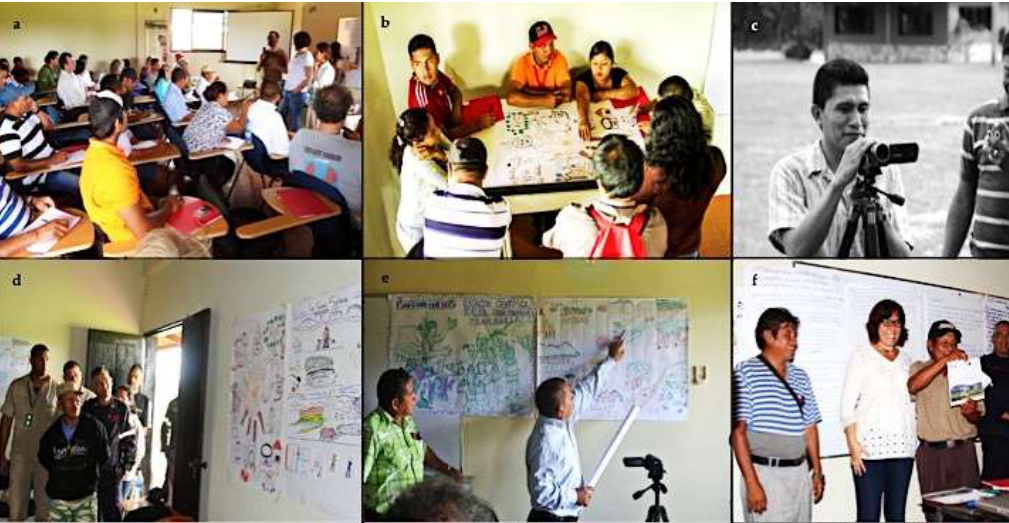
Figure 2. Illustrative images of the activities carried out during the workshop: ( a ) general view of the participants and organizers (in this image from left to the right: Andrea Berardi, Bibiana Bilbao, and Jay Mistry) of the workshop; this workshop gathered more than 60 Indigenous, institutional, and academic representatives from more than 27 organizations working on fire issues in the central region of the Guiana Shield of Venezuela, Brazil, and Guyana. ( b ) Group work formed by members of diverse Indigenous Pemón communities. ( c ) Participants from Indigenous communities from Brazil recording on video the activities of the workshop. ( d ) Firefighters from National Institute of Parks (INPARQUES, acronym in Spanish) and Vegetation Wildfires Control Program (PCIV, acronym in Spanish) of National Electric Company (CORPOELEC, acronym in Spanish) formerly Electrification of Caroní (Edelca, Acronym in Spanish), describing their rich picture results. ( e ) Indigenous representatives from Guyana presenting their results about traditional fire management. (f ) Workshop organizers hand Attendance Certificates to all participants. In this image Valeriano Constati (center), leader of the Pem ó n people certificate (from left to right: Filiberto Lambos, captain of the Indigenous community of Kavanay é